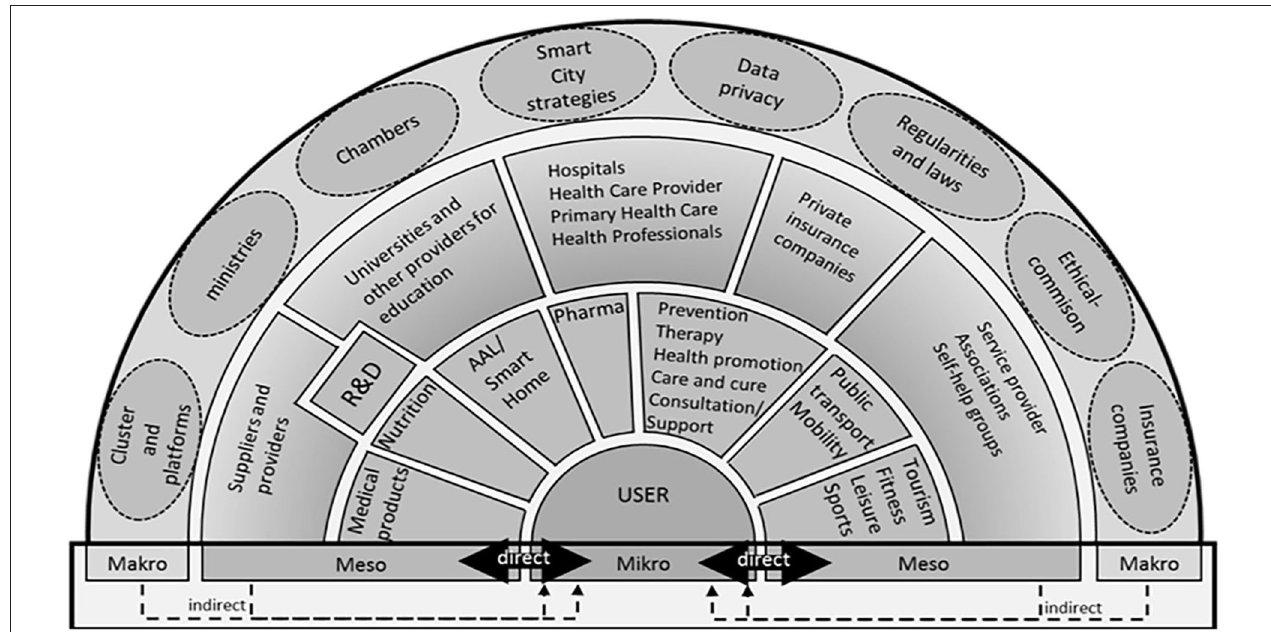
FIGURE 3 | Humans, institutions and legal bodies and their position in the active and healthy aging ecosystem Styria according to results from the study presented in the current publication. In a mixed-model approach it was possible to condense information on regional structure and processes with evidence gathered during a literature search and feedback collected in face to face interviews and workshops with regional experts and